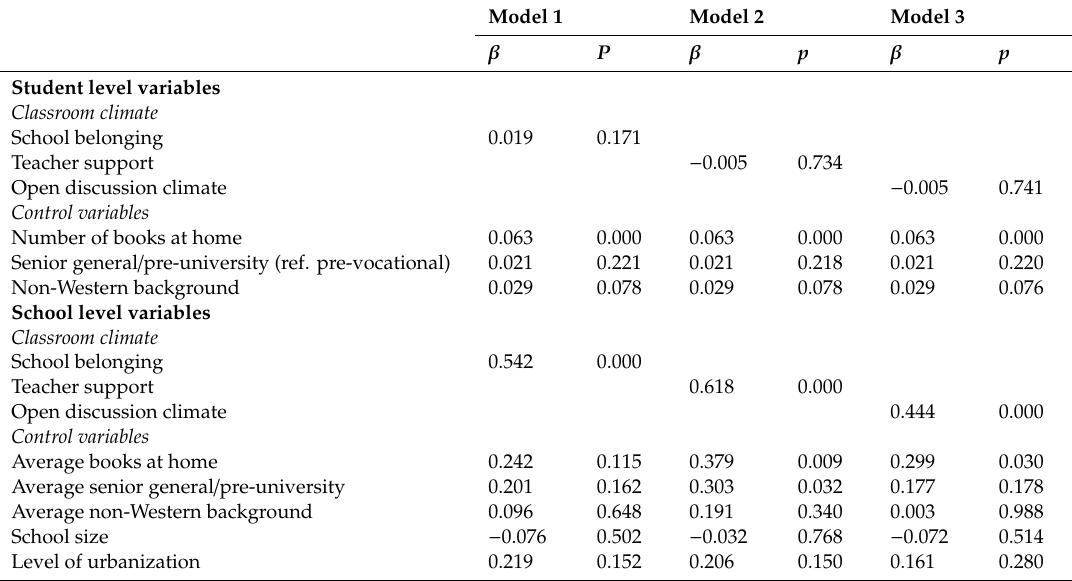
Table A8. Classroom climate e ff ects on citizenship skills (standardized